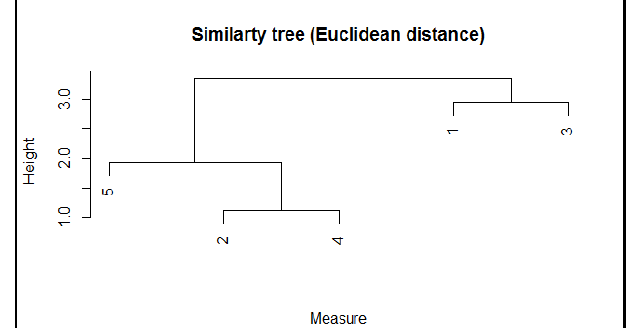
Figure 2 : The similarity tree of the measures With threshold clustering h=3, the measures are classified into two clusters: L 1 ={2,4,5}; L 2